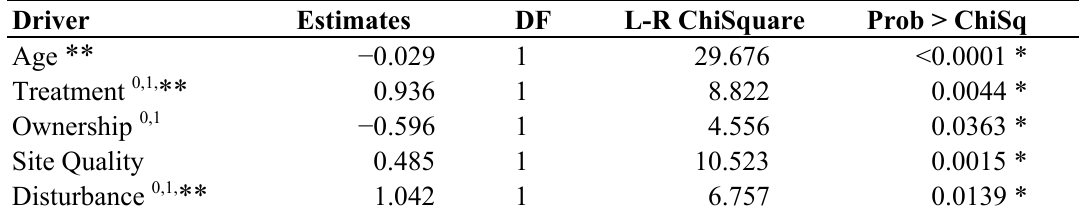
Table 5. Effect likelihood ratio tests and parameter estimates for synergy (1) and